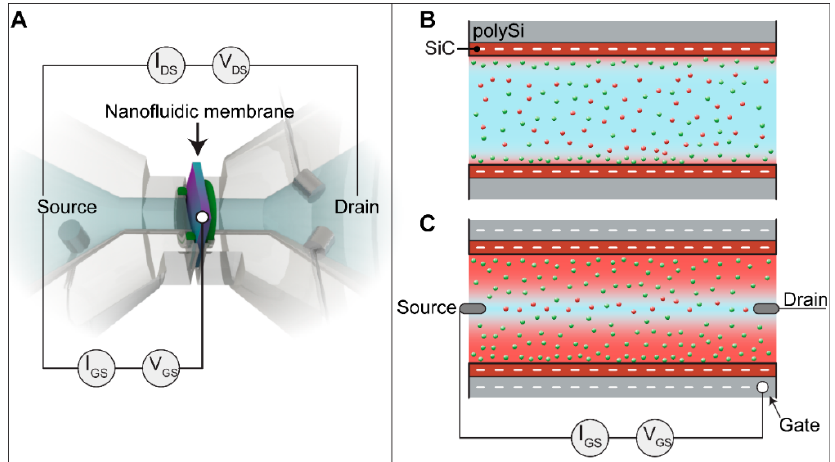
Figure 3. ( A ). To perform the I-V and conductance measurements, transmembrane potential V DS is applied between the source electrode and drain electrode in the reservoir, and gate potential V GS is applied between the source electrode in the reservoir and the buried gate electrode of the membrane. ( B ) Telescopic illustration of the nanochannel wall and the buried gate electrode. ( C ). Application of gate potential V GS that polarizes the surface of the nanochannel wall, leading to alteration of the conductance of the charged species and, consequently, modulation of the ionic current I DS .